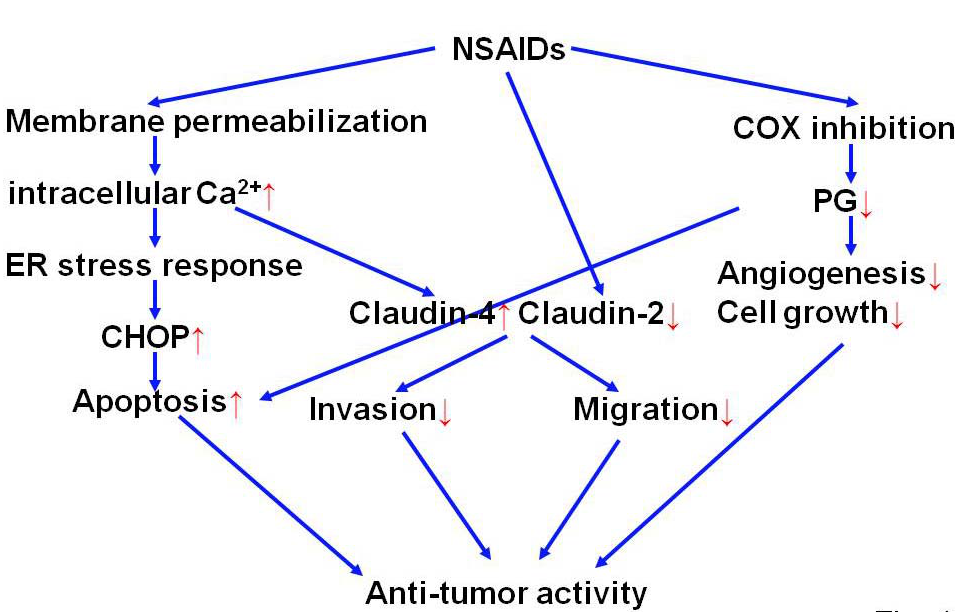
Figure 4. Mechanism for anti-tumor activity of